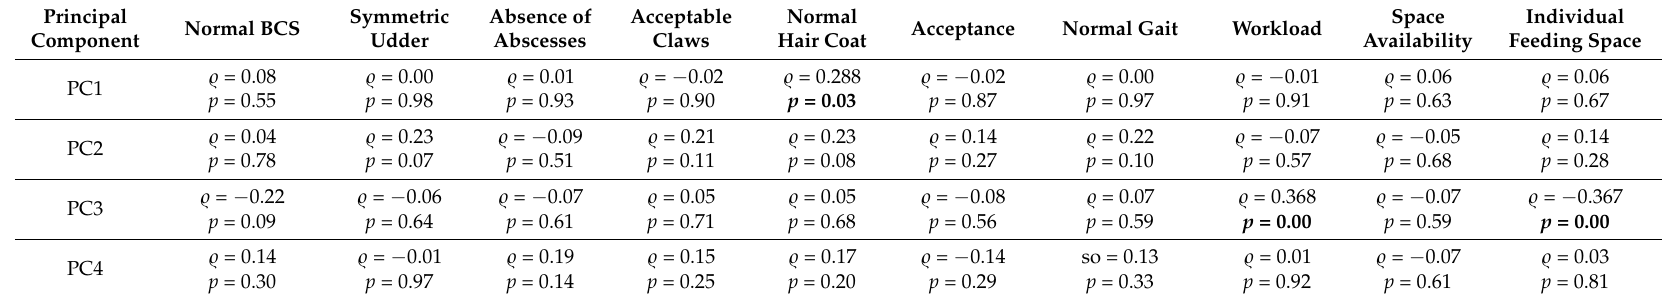
Table 4. Correlations between the first four Principal Components (PCs) and the selected ABMs and RBMs. Statistical differences are bold typed. Principal